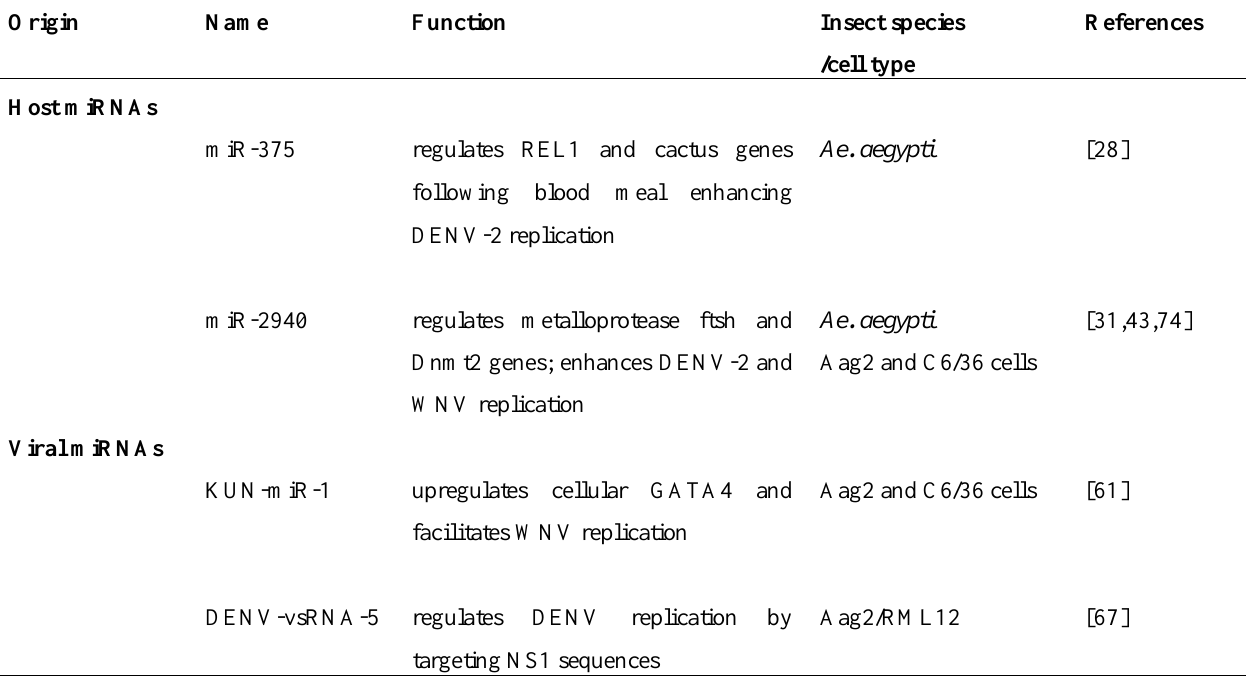
Table 1. miRNAs with validated function in arbovirus-host